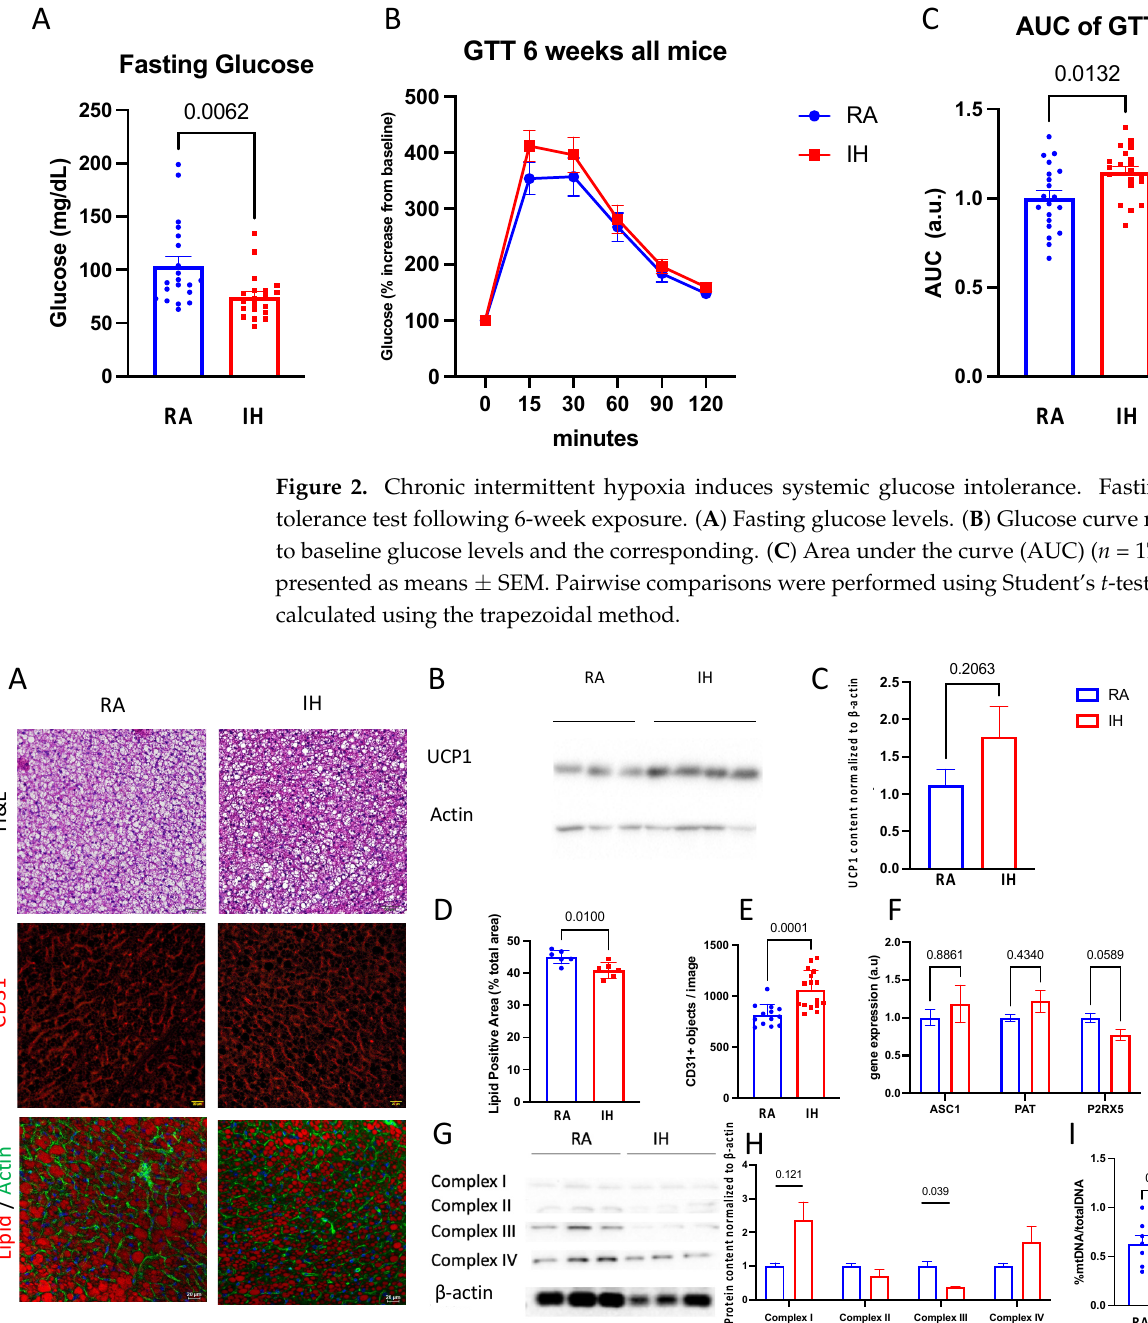
Figure 3. Chronic intermittent hypoxia promotes the browning of interscapular BAT with evidence for mitochondrial dysfunction. Phenotypic changes in BAT following chronic intermittent exposures compared with room air controls. ( A ) Representative images of BAT from the experimental groups: H&E (top row), vascular marker CD31 (middle row), and lipid-staining Neil Red with Actin-staining phalloidin (bottom row), bar = 20 μ m. ( B , C ) Western blot analysis of UCP1 expression in BAT, normalized to β -actin. ( D ) Quantification of lipid positive area, and ( E ) Vessel density (5–6 randomly selected images from each slide, n = 3 biological replicates). ( F ) mRNA levels of 3 markers of adipose tissue phenotype ASC1 (white), PAT (beige), and P2PRX5 (brown). ( G , H ) Western blot analysis of the expression of mitochondrial electron transport chain proteins normalized to β -actin. ( I ) Mitochondrial DNA quantification normalized to genomic DNA amount (B2M). Data are presented as mean ± SEM. Pairwise comparisons were performed using Student’s t -test.